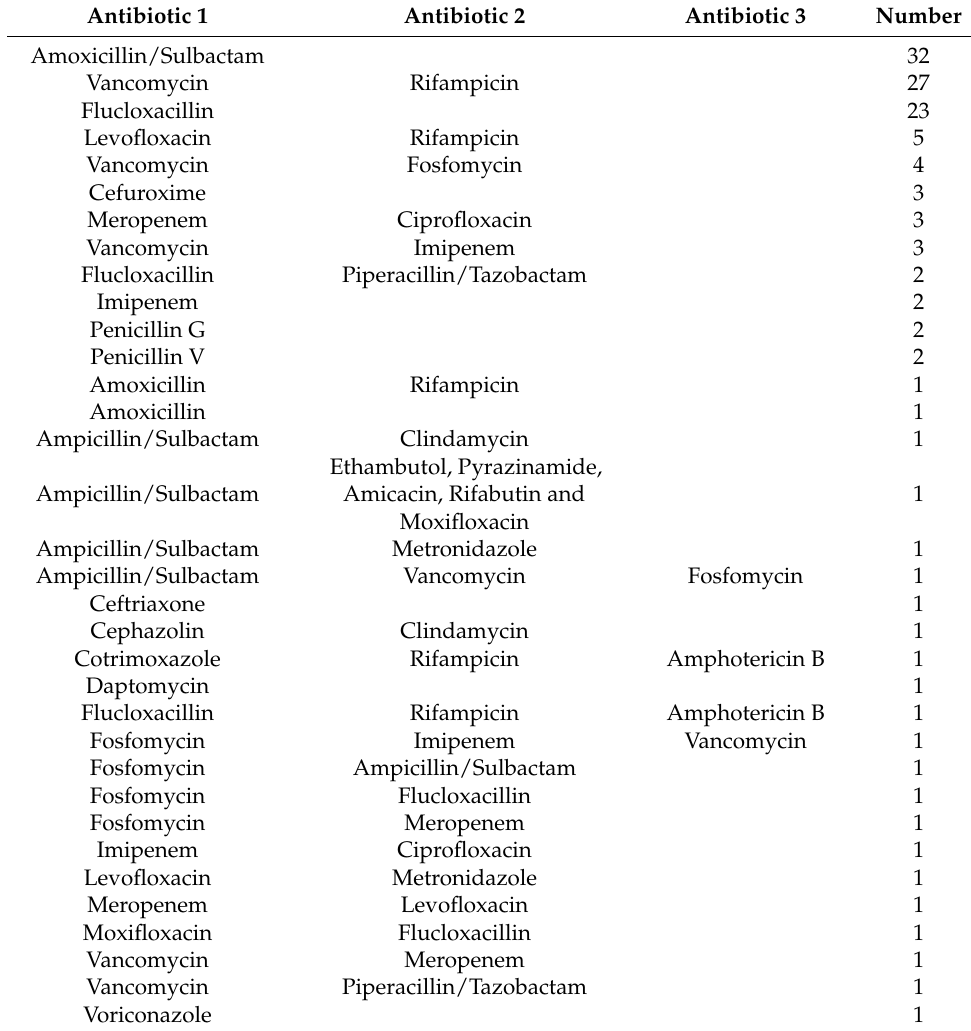
Table 4. Intravenously administered anti-infective substances or combination of anti-infective sub- stances with number of